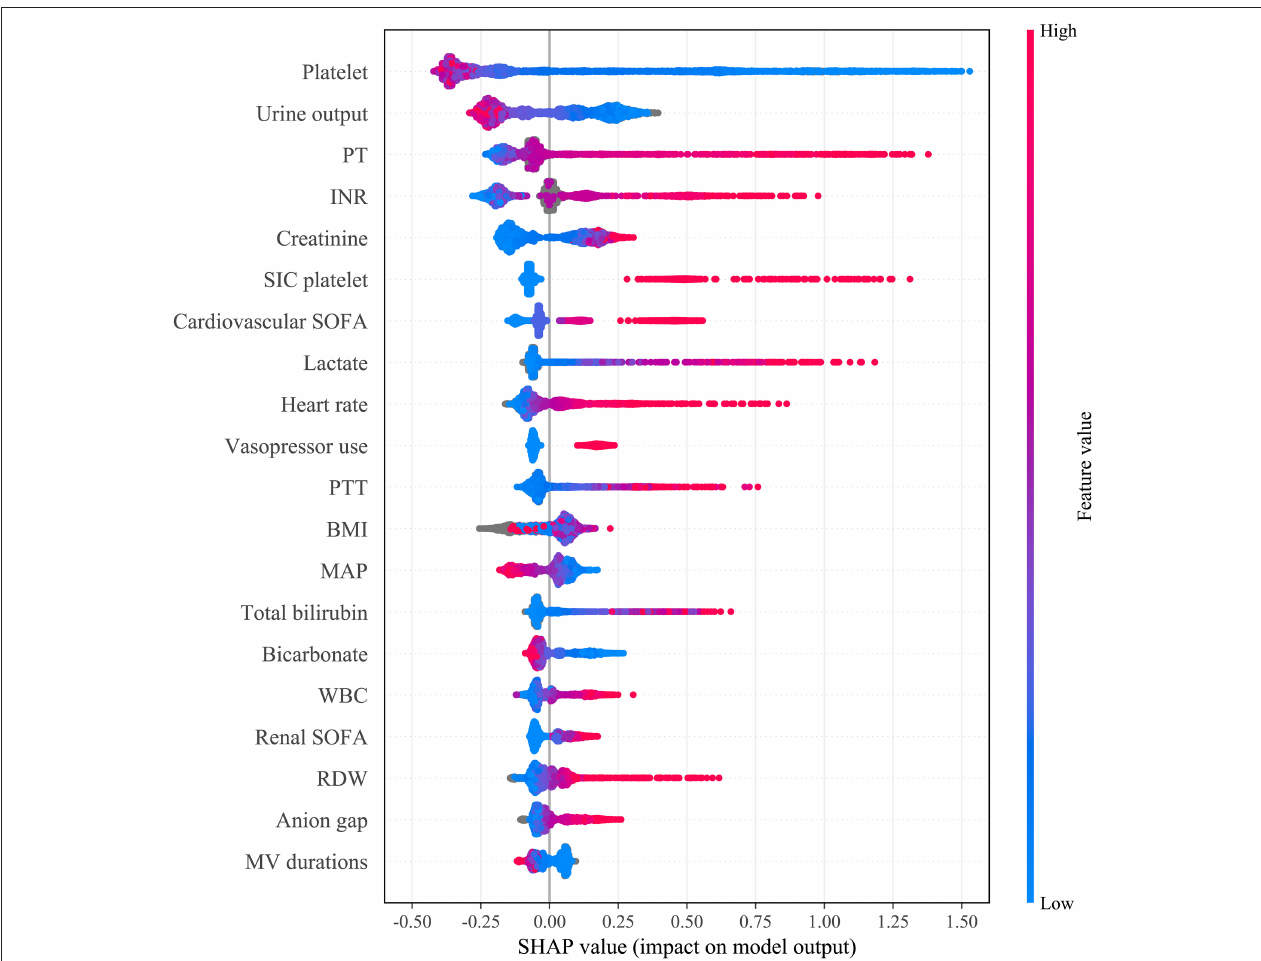
FIGURE 3 | Distribution of the impact each feature had on the full model output estimated using the SHapley Additive exPlanations (SHAP) values. The plot sorts features by the sum of SHAP value magnitudes over all samples. The color represents the feature value (red high, blue low). The x axis measures the impact on the model output (right positive, left negative). Taking the feature platelet as an example, red points are on the left whereas blue points are on the right. This means prediction scores will be smaller when patients have a low level of platelets. PT, prothrombin time; INR, international normalized ratio; SIC, sepsis-induced coagulopathy; SIC platelet, platelet term in the SIC score; SOFA, sequential organ failure assessment; PTT, Partial Thromboplastin Time; BMI, body mass index; MAP, mean arterial pressure; WBC, white blood cell count; RDW, red cell distribution width; MV, mechanical ventilation.